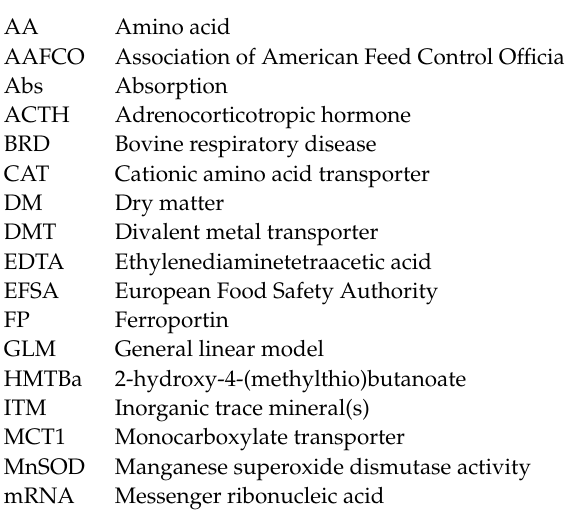
bioavailability of supplemental copper sources: Table S1. Cattle; Table S2. Poultry; Table S3. Sheep; Table S4. Swine Individual species tables for relative bioavailability of supplemental iron sources; Table S5. Cattle; Table S6. Poultry; Table S7. Sheep; Table S8. Swine; Individual species tables for rela- tive bioavailability of supplemental manganese sources; Table S9. Poultry; Table S10. Sheep; Table S11. Swine; Individual species tables for relative bioavailability of supplemental zinc sources; Table S12. Cattle; Table S13. Poultry—Chickens; Table S14. Poultry—Turkeys; Table S15. Poultry—Japanese Quail; Table S16. Sheep; Table S17.